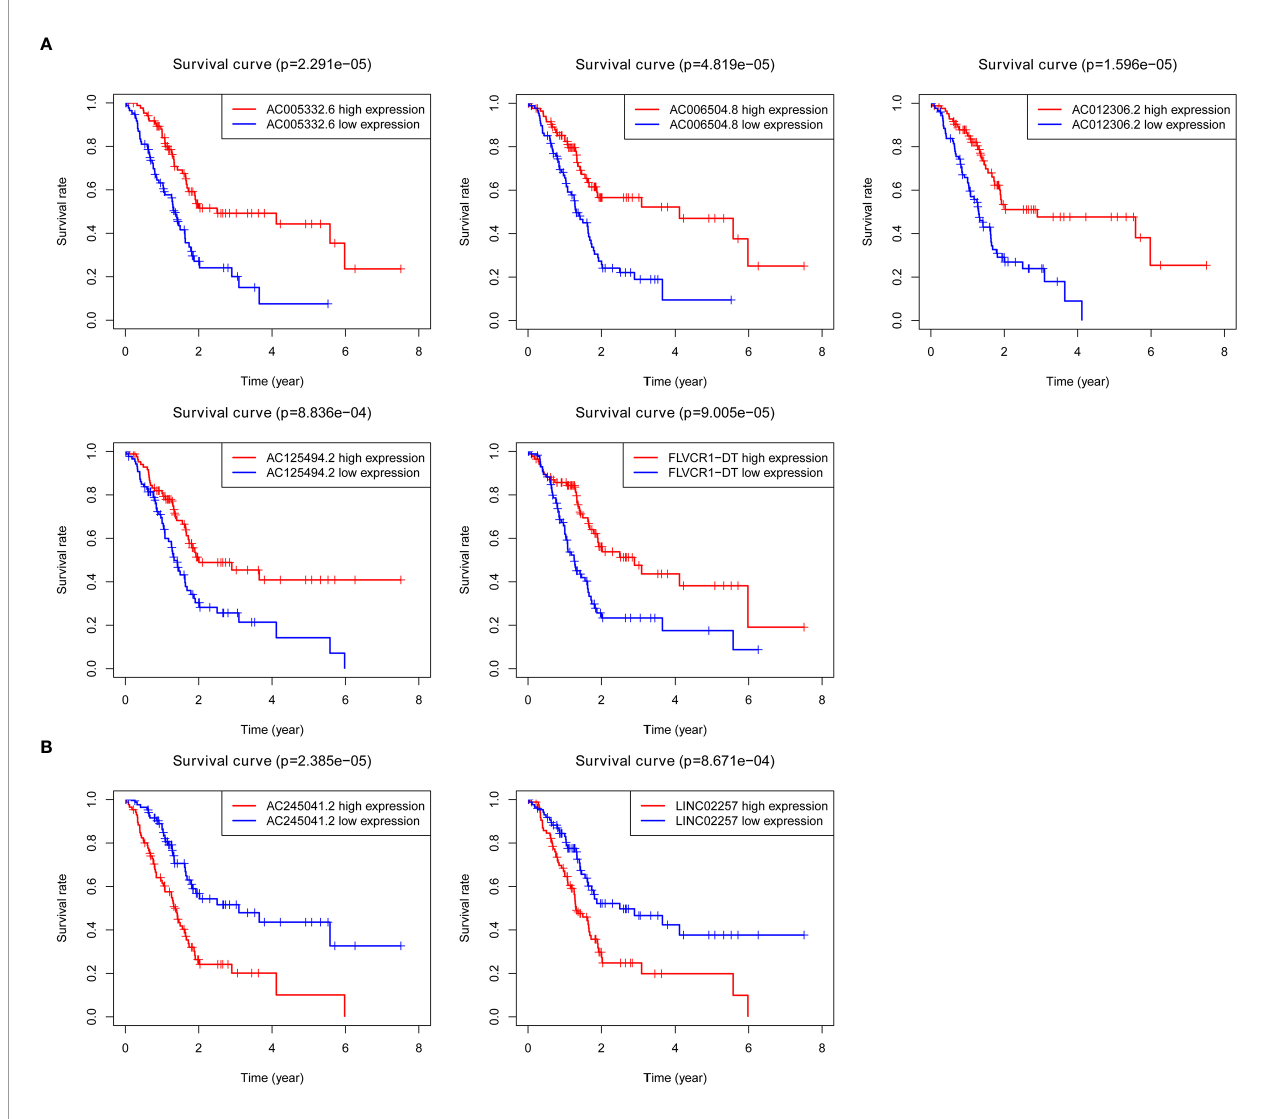
FIGURE 1 | Survival analysis for autophagy-associated lncRNAs. Kaplan – Meier survival curves for autophagy-associated lncRNAs that were positively (A) or negatively (B) related to OS in PC